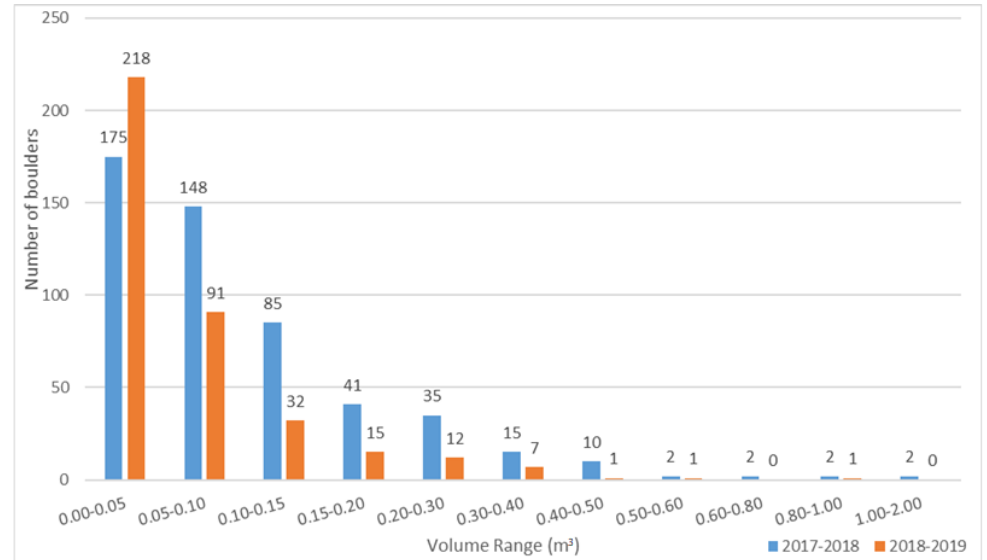
Figure 16. Volume distribution of moving boulders in different time periods. More than half of the movable boulders were smaller than 0.1 m 3 , especially in the 2018–2019 period. The 2017–2018 period saw a greater number of larger boulders being moved. ( 𝑉 𝑒 ), M3C2 volume ( 𝑉 𝑀 ), and error percentage ( 𝑒 𝑝 ) calculated.